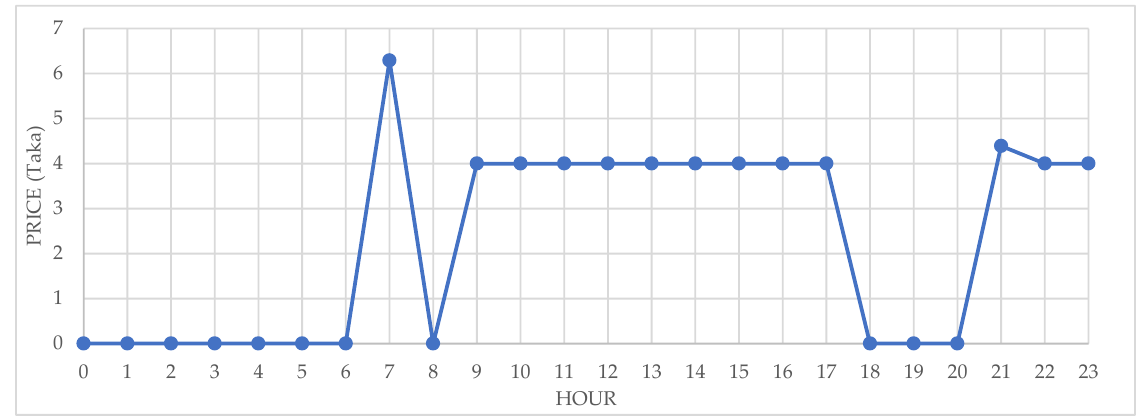
Figure 10. Hourly internal selling price of the prosumer .